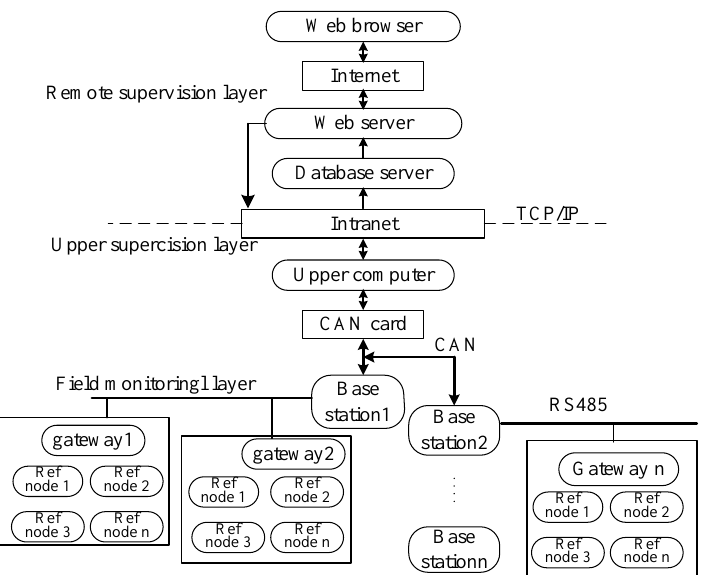
Figure 1. Architecture of